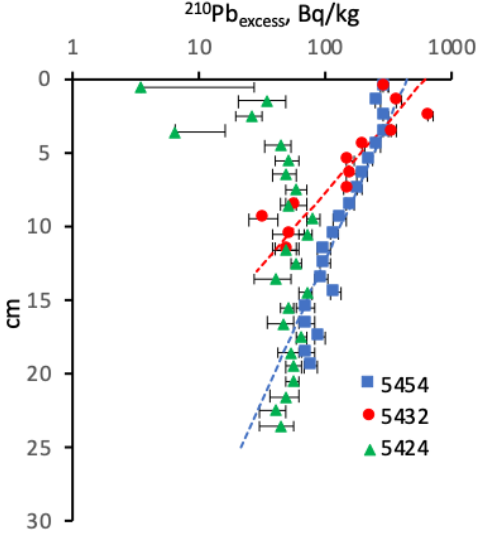
Figure 5. Excess 210 Pb vertical profile from AMK-5424, -5432, and -5454 sediment cores.